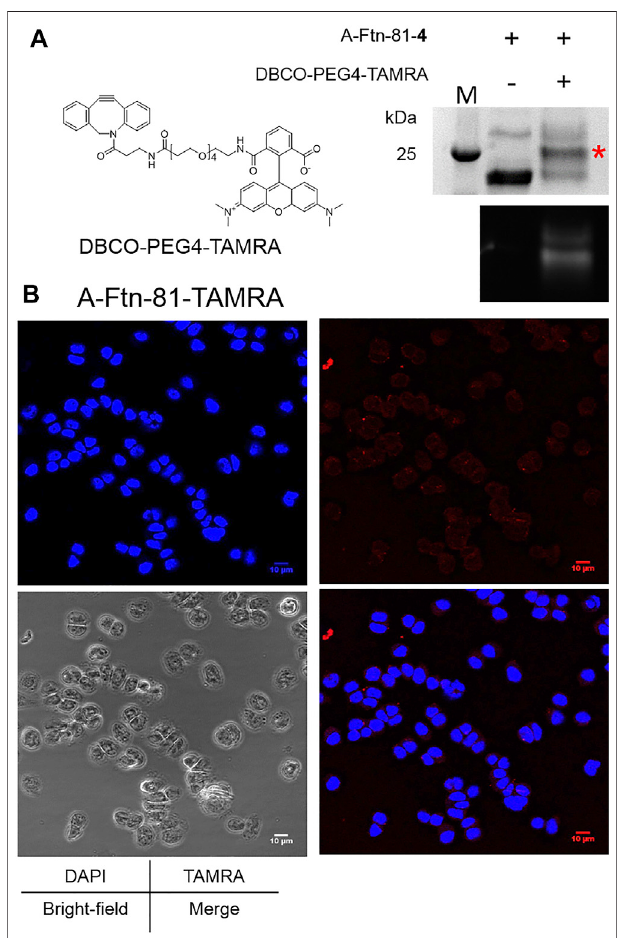
FIGURE6| A-Ftn-TAMRA conjugates treatment indicates Her2 + BT474 cell targeting ability. (A) Chemical structure of DBCO-PEG4-TAMRA and SPAAC labeling analysis after the treatment of A-Ftn-81-4 with DBCO-PEG4- TAMRA. Proteins are analyzed by 15% SDS-PAGE with Instant Blue staining (upper panel) and gel fl uorescence emission image (lower panel) . The red asterisk indicates the TAMRA-labeled Ftn band. M denotes the protein molecular weight marker. (B) Confocal microscopy fl uorescence image analysis of BT474 cells incubated with 2 μ M A-Ftn-81-TAMRA for 1 h. The cell nuclei are stained by DAPI (blue); A-Ftn-81-TAMRA is detected by TAMRA ( λ ex / λ em (cid:2) 553 nm/563 nm, red).